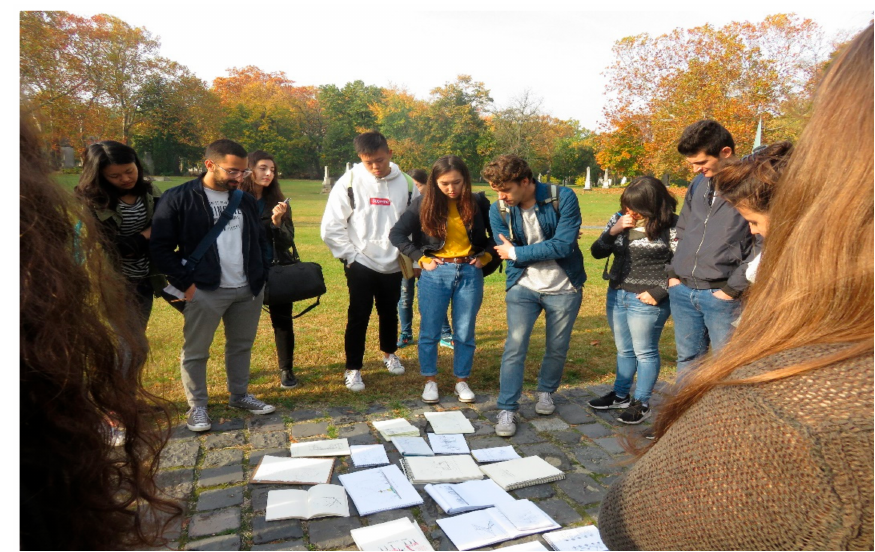
Figure 7. Presentation and discussion of results of fieldwork from notebooks on site creates a huge learning effect because feedback is given almost immediately for the whole group. It has also a stimulating effect on all students because they see on the spot how others have approached and graphically represented the work on the spot in a limited